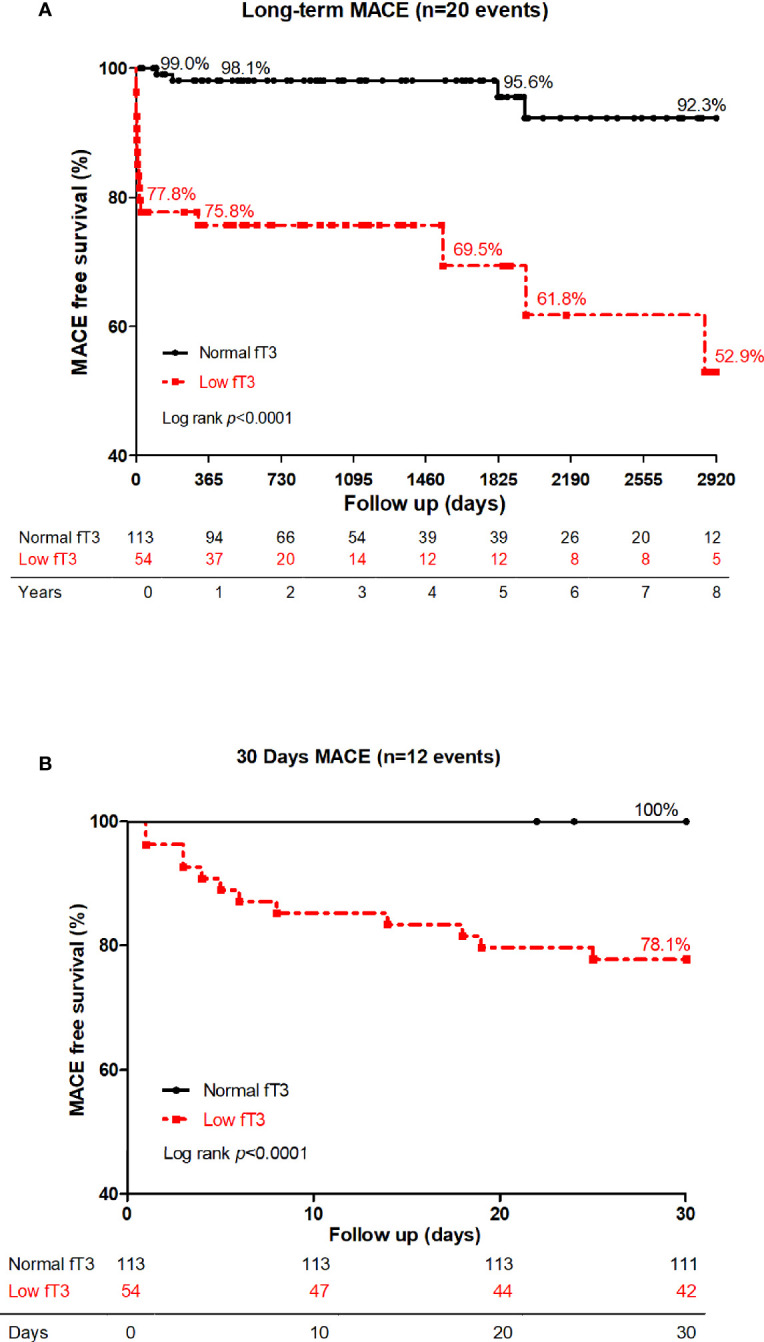
Long-term (A) and 30-day (B) MACE-free survival in low fT3 group versus normal fT3 group in patients with acute myocarditis. Patients with low fT3 syndrome had more MACE in 30 days as well as in the long-term. MACE included deaths, heart transplantations, re-hospitalization for heart failure and sustained ventricular arrhythmias (>30s).